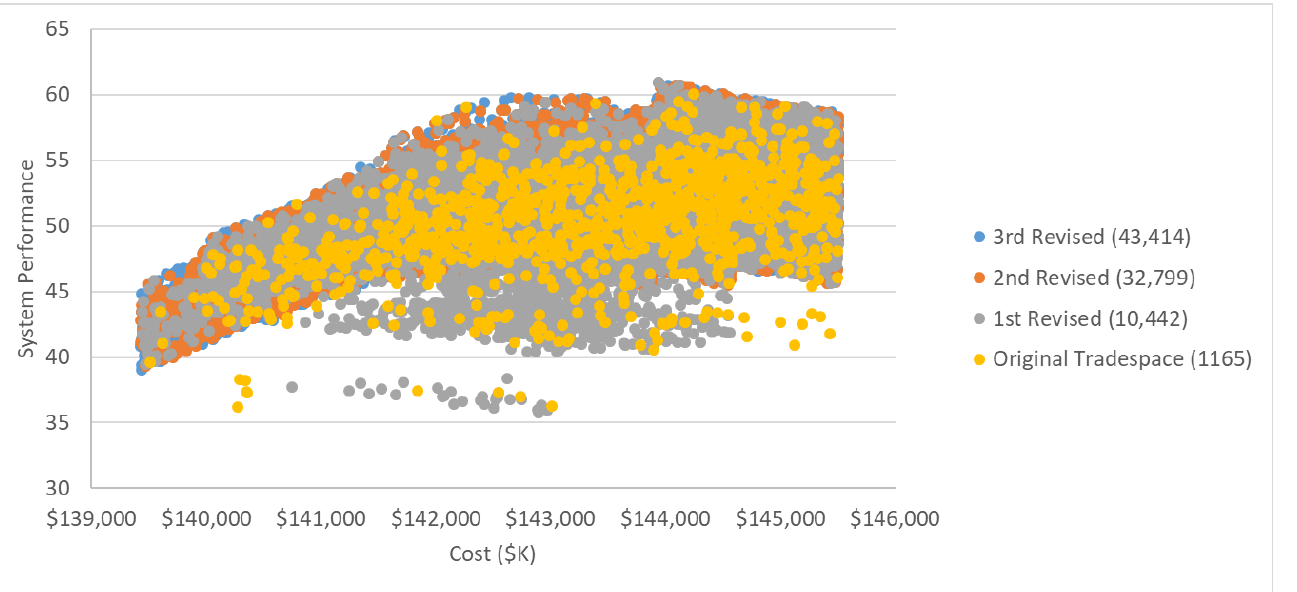
Figure 16. Tradespace Evaluation Comparison.